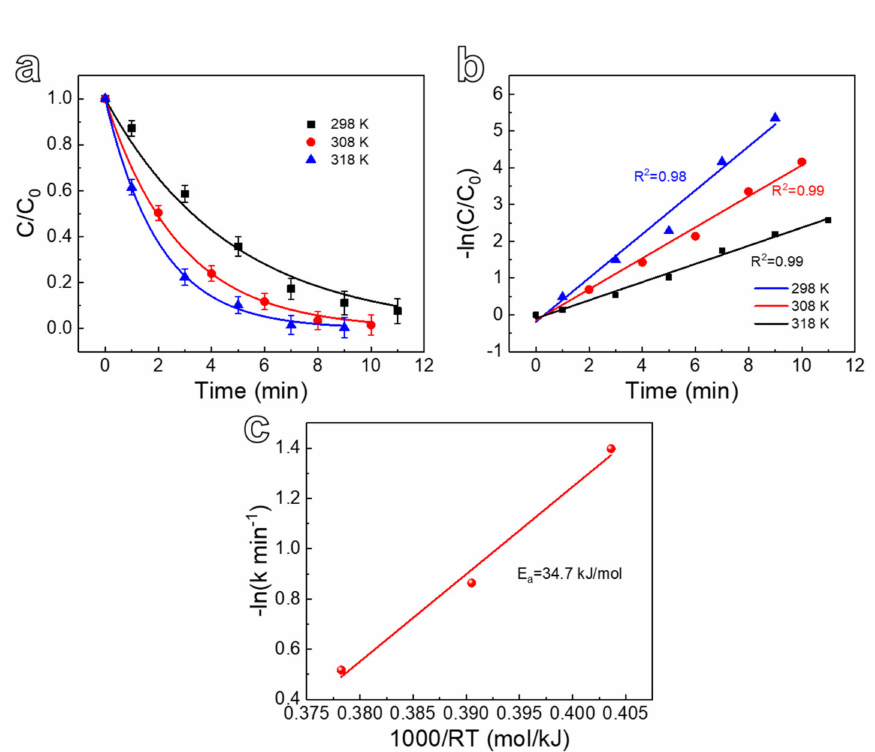
Figure 7. ( a ) Degradation properties of Co 3 O 4 @NP-CuO composite at different temperatures, ( b ) corresponding L-H pseudo-first-order dynamic model and, ( c ) Arrhenius